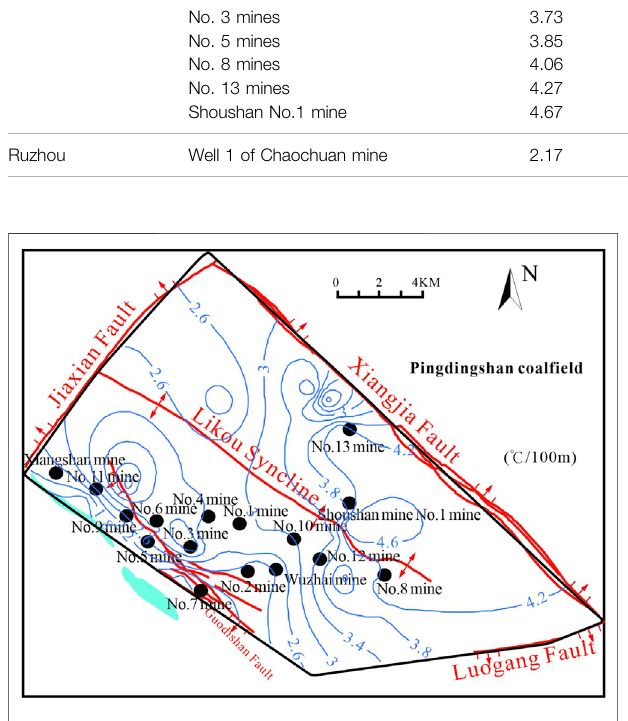
FIGURE 3 | Contour map of the geothermal gradient in the Pingdingshan coal fi eld.